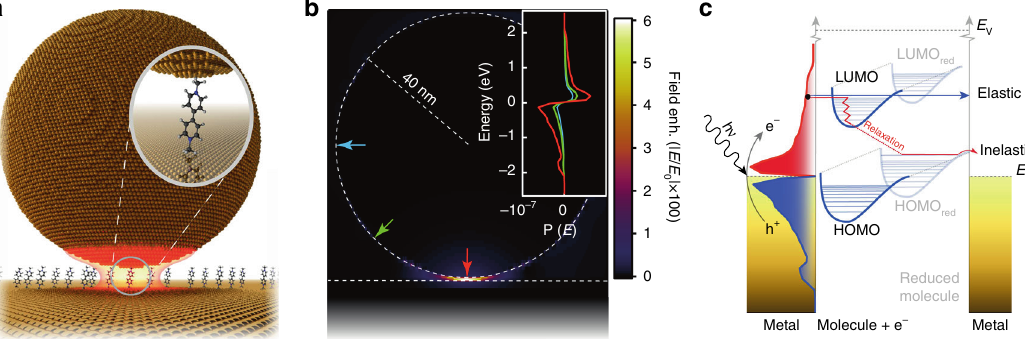
Fig. 1 Plasmon generated hot charge carrier transport in a nanoparticle-on-mirror geometry. a Self-assembled 80 nm nanoparticle-on-mirror geometry used to elicit fi eld enhancements required for single-molecule spectroscopy. b FDTD-calculated electric fi eld enhancement ( E max / E 0 > 600) for structure in a at 760 nm. Inset: plasmon-induced hot carrier population for different points around the NPoM geometry (marked with coloured arrows, calculated at 633 nm). c Schematic representation which depicts the plasmon-induced hot electron transfer between Au nanoparticles and unoccupied